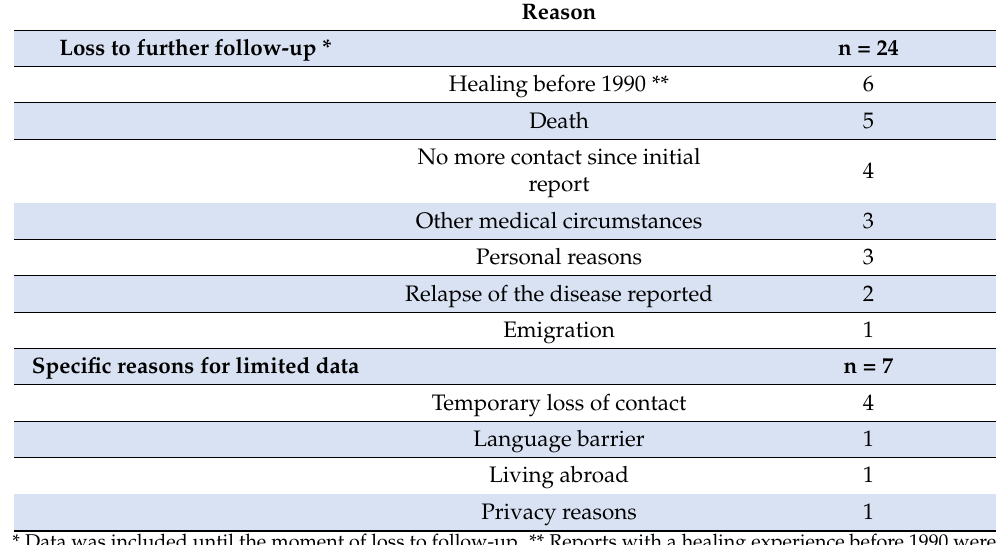
Table 3. Reasons for limited availability of data.